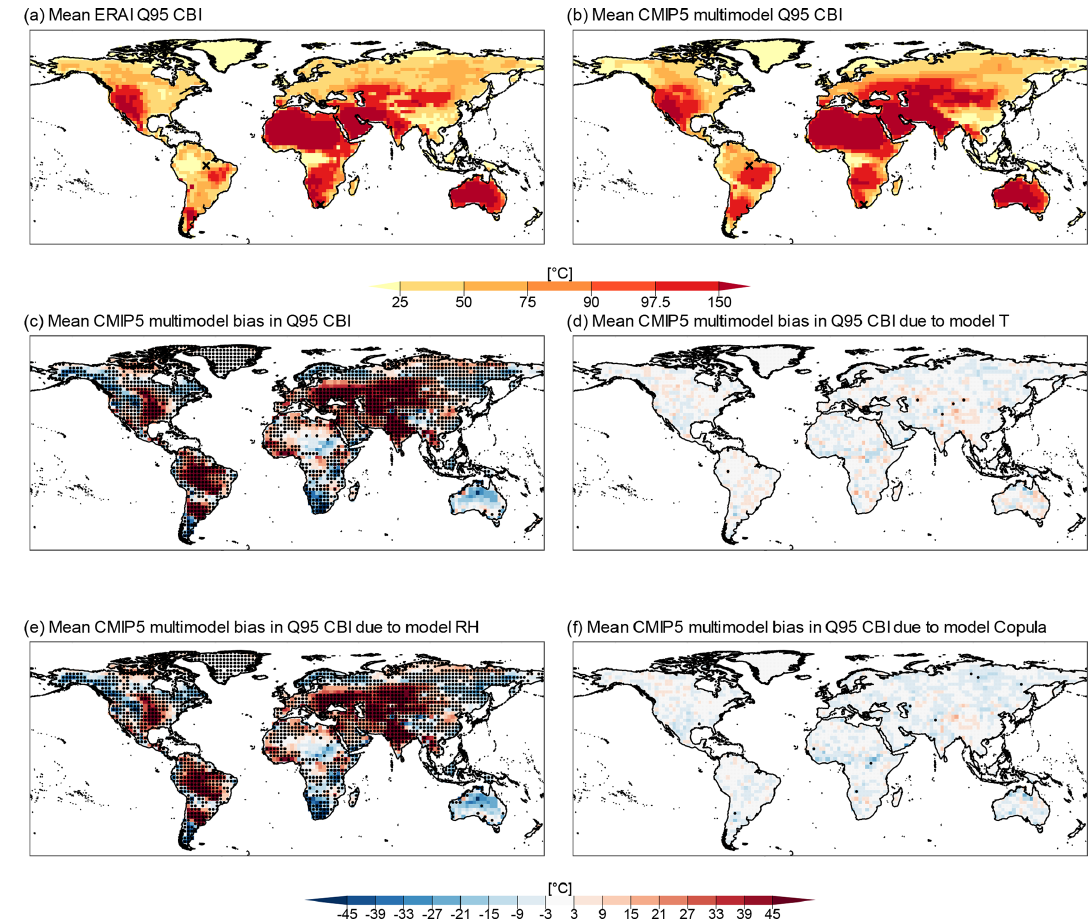
Figure 5. ERA-Interim (a) and CMIP5 multimodel mean (b) 95th quantile CBI values. Note that the palette is non-linear, as it follows typical defined ranges of fire hazard levels based on the CBI, i.e. very low, low, moderate, high, very high, and extreme. Mean CMIP5 multimodel bias in Q95 CBI (c) , and its decomposition into bias due to the T (d) , RH (e) , and copula (f) components of the models. Stippling indicates locations where more than 75% of CMIP5 model sample values lie outside the 95% confidence interval for ERA-Interim estimated based on bootstrap samples. Bias was calculated as (CMIP5 or transformation minus